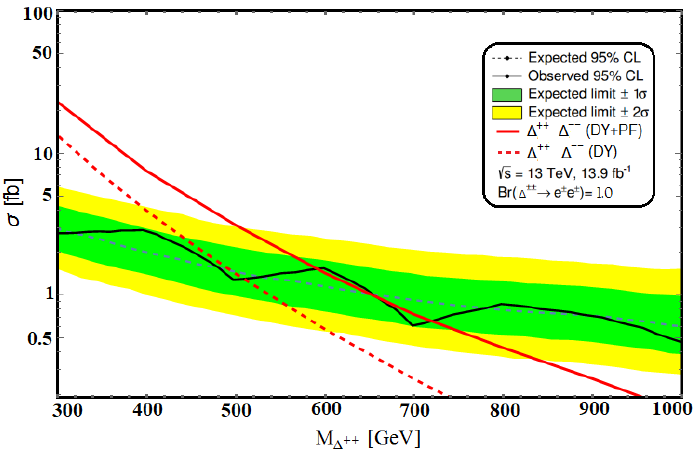
Figure 13 . The observed and expected 95% C.L. upper limits of the production cross-section (cid:2) (cid:3) times branching ratio to electrons (cid:27) ((cid:1) ++ (cid:1) (cid:0)(cid:0) ) (cid:2) Br ((cid:1) (cid:6)(cid:6) ! e (cid:6) e (cid:6) ) as a function of M using (cid:1) (cid:6)(cid:6) p ATLAS results [1] at s = 13 TeV with 13.9 fb (cid:0) 1 integrated luminosity. The theoretical prediction for (cid:27) ((cid:1) ++ (cid:1) (cid:0)(cid:0) ) (cid:2) Br ((cid:1) (cid:6)(cid:6) ! e (cid:6) e (cid:6) ) in the context of present model for a SU(2) L quadruplet doubly charged scalar are presented by red solid (photon fusion + DY) and dashed (DY-only) lines. In the calculation of the theoretical cross-section, we have assumed Br ((cid:1) (cid:6)(cid:6) ! e (cid:6) e (cid:6) ) (cid:24) 100%.